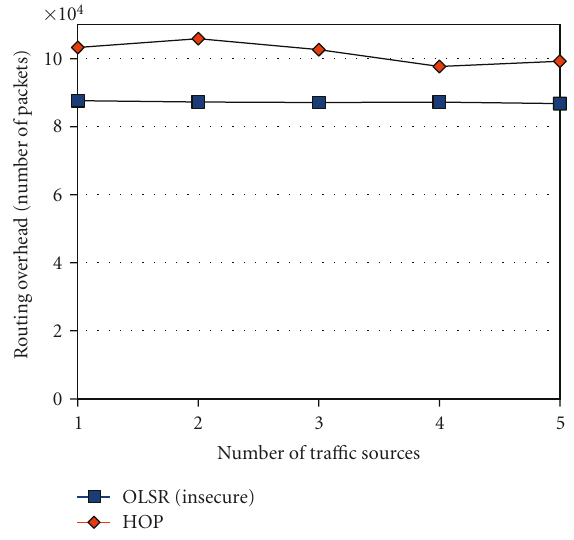
Figure 14: Routing overhead for OLSR and the HOP solution when increasing the aggregated load in the